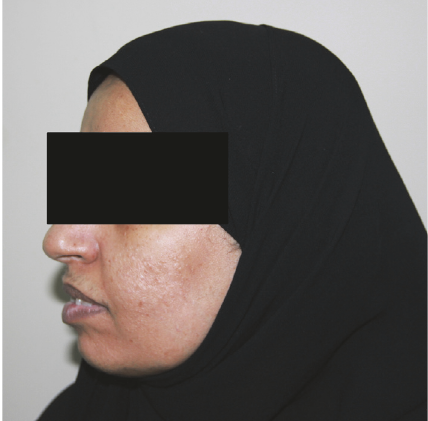
Figure 1: Clinical picture of the patient demonstrating the pitted skin of the cheeks.